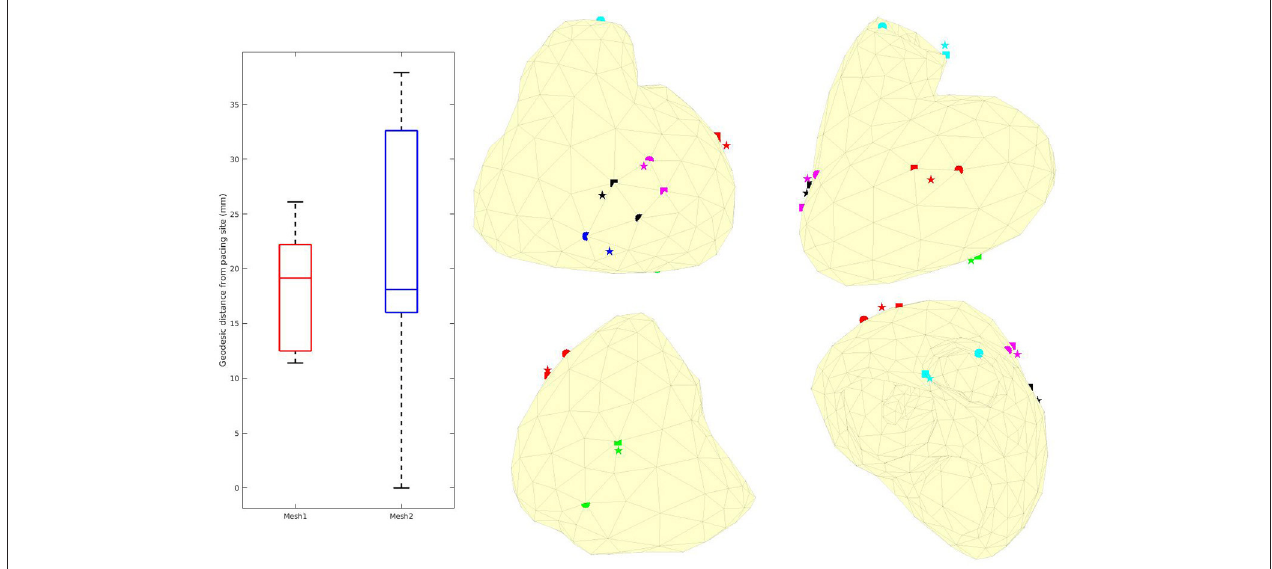
FIGURE 12 | Left : Box plots of the geodesic distances between actual and identified pacing sites. Middle and right : actual (sphere), identified with Mesh1 (pentagram) and Mesh2 (square) pacing locations. Red: case 1, blue: case 3, green: case 4, black: case 5, cyan: case 6, magenta: case 7. We obtained a p -value of